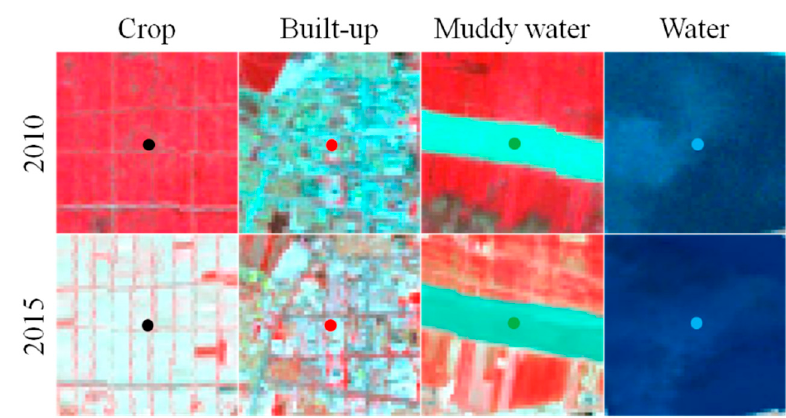
Figure 10. Land cover sampling in the years 2010 and 2015, where the black, red, green, and blue dots denote the sampling pixel location. The backgrounds are the Landsat images with the same scale.